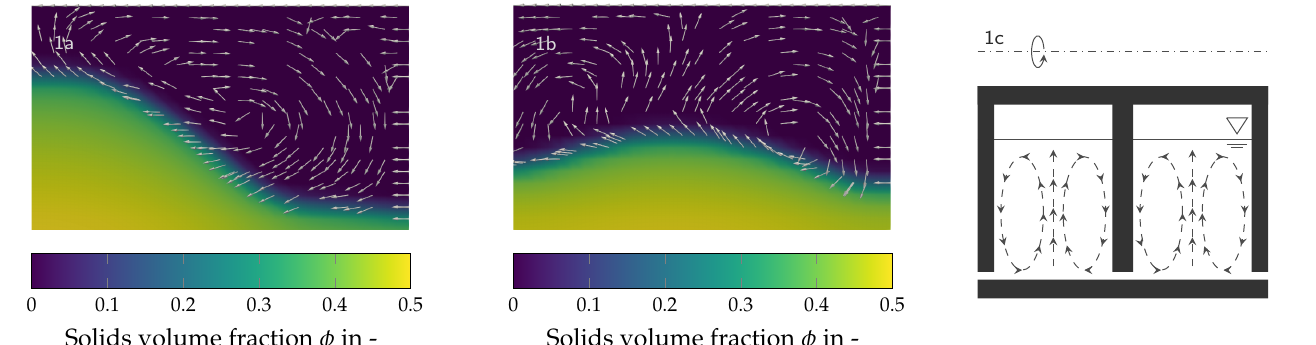
Figure 9. Velocity distribution without sliding feed of the screw: sediment with yield point ( 1a ), sediment without yield point ( 1b ), theoretical consideration of the disc stirrer effect within the screw channel ( 1c ) according to Stahl [11]. The evaluation was performed on the cut surface marked in blue in Figure